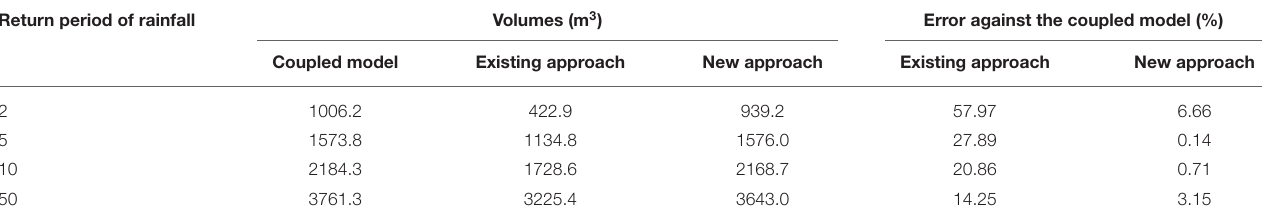
TABLE 1 | Comparison of volumes with different approaches and error vs. the coupled model (5th h). Return period of